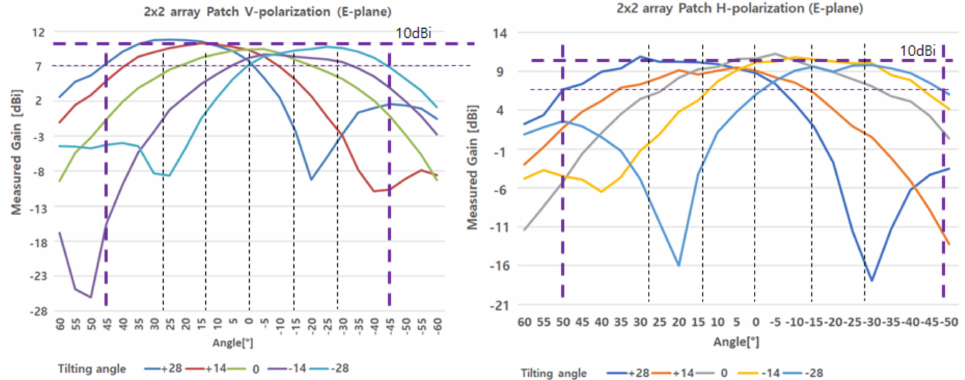
Figure 17. Results of the beam tilting of the 2 × 2 array